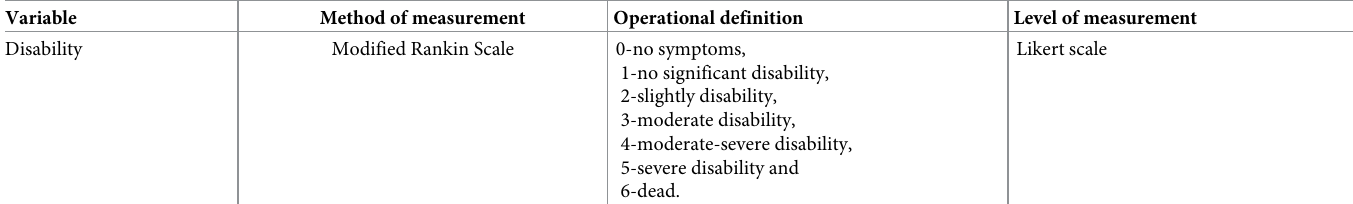
Table 4. Summary and description of objective number 4 variables of the study.